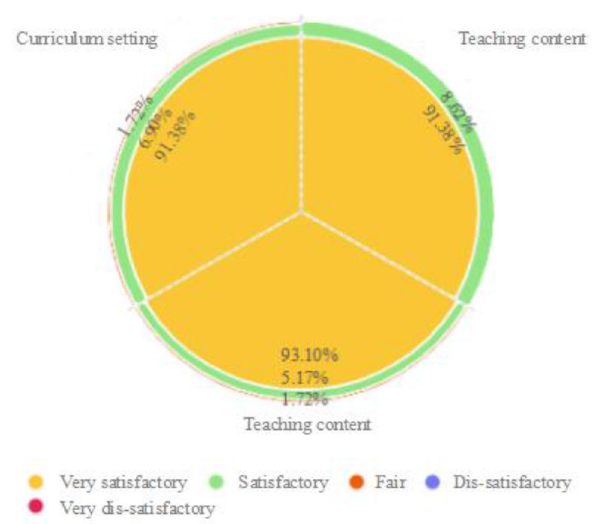
Fig. 3 Students’ satisfaction of course